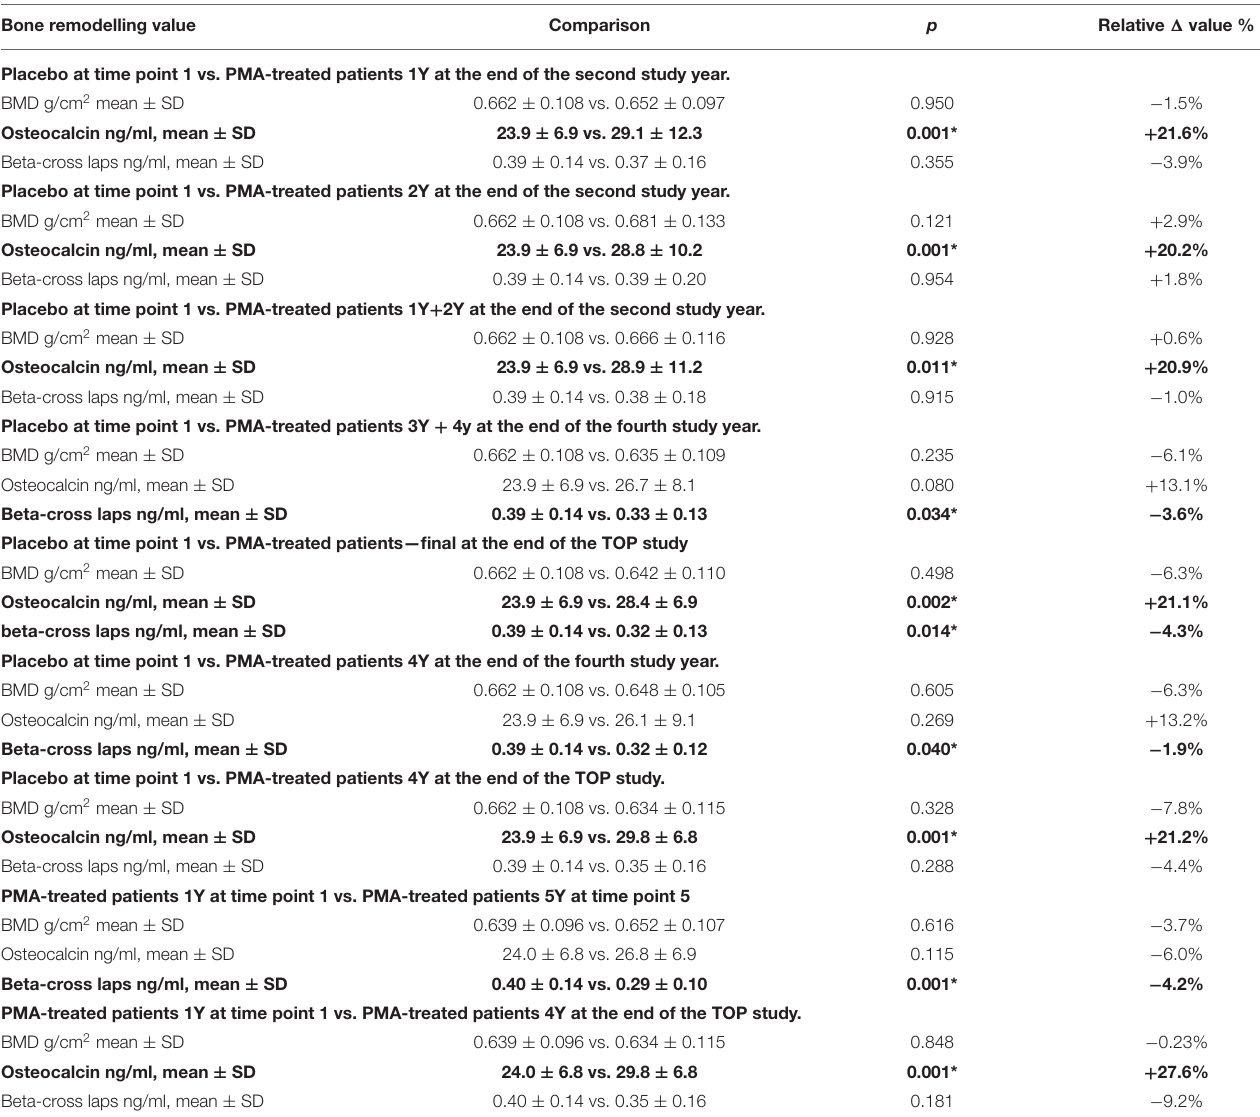
TABLE 1 | Statistically relevant differences for analyzed bone surrogate metabolic markers (BMD, osteocalcin and beta-cross laps) values in patients according to the tested time-points. Bone remodelling value Comparison p Relative 1 value